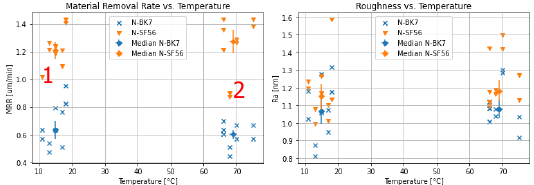
Fig. 4. MRR as function of the temperature for five tests with N- BK7 and N-SF56. The number of datapoints is 10 for each temperature range and glass type, sometimes datapoints overlap (e. g. point 1 or point 2) (left side) and roughness R a as function of the temperature of the polishing slurry. (right